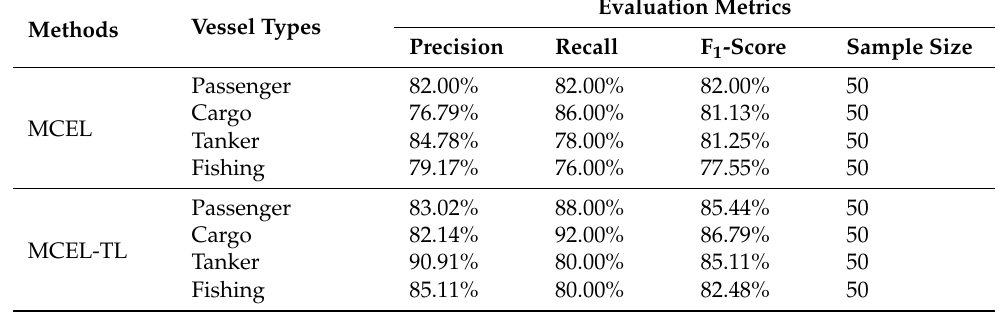
Table 5. SAR ship classification performance of the MECL with different training samples.